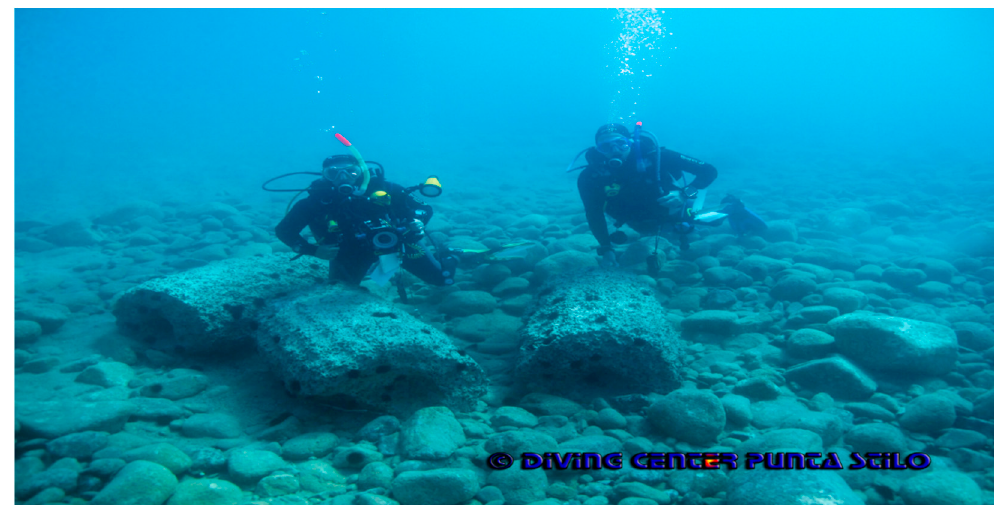
Figure 3. An example of submerged archeological items lying on the seafloor subjected to several underwater environmental factors such as sea current and the nature of the seabed. Biodeterioration is mainly due to the activity of micro- and macro-foulers depending on the position of the items (Photo, Alfina and Mario Tassone, Diving Center Punta Stilo, Calabria, Italy).